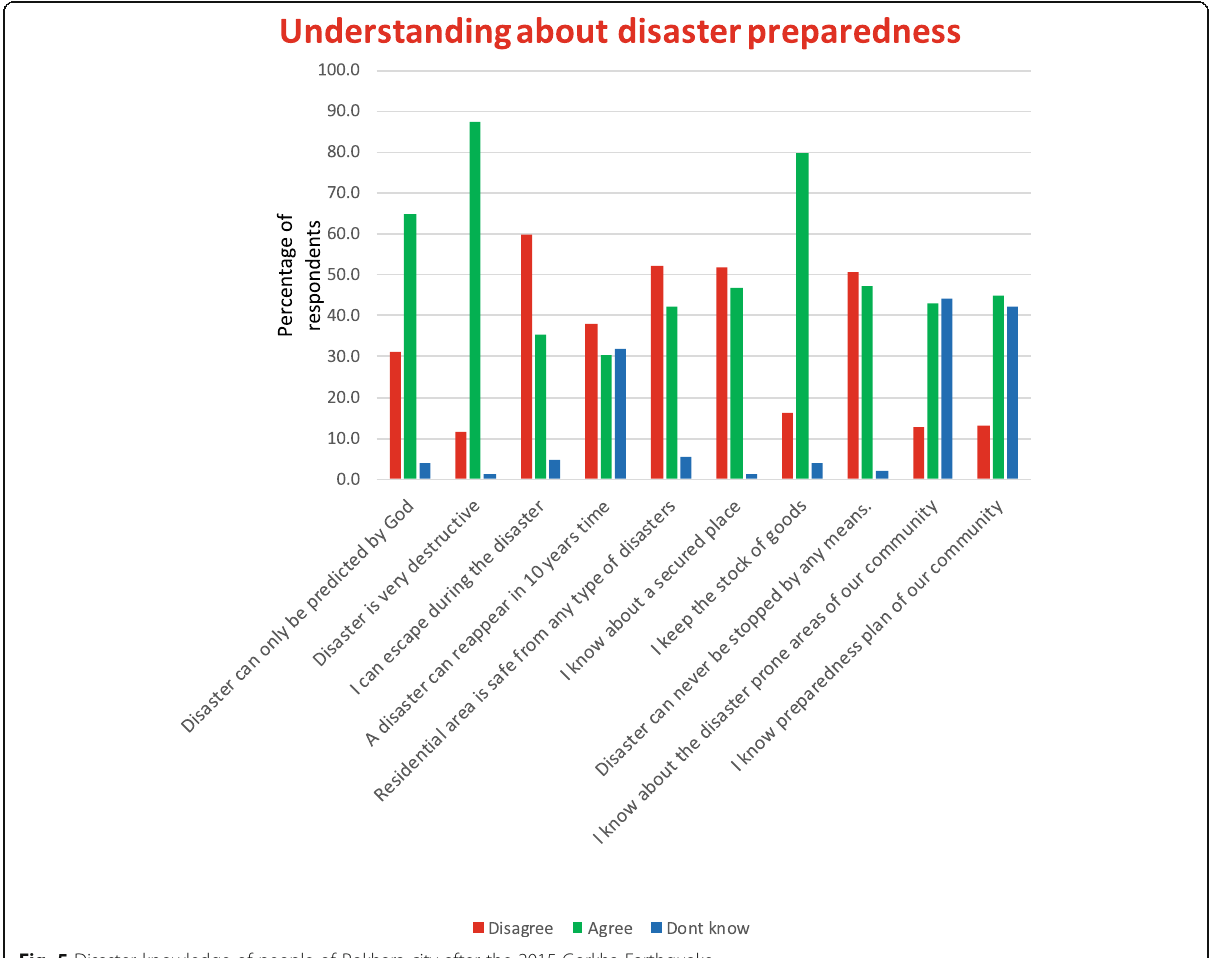
Fig. 5 Disaster knowledge of people of Pokhara city after the 2015 Gorkha